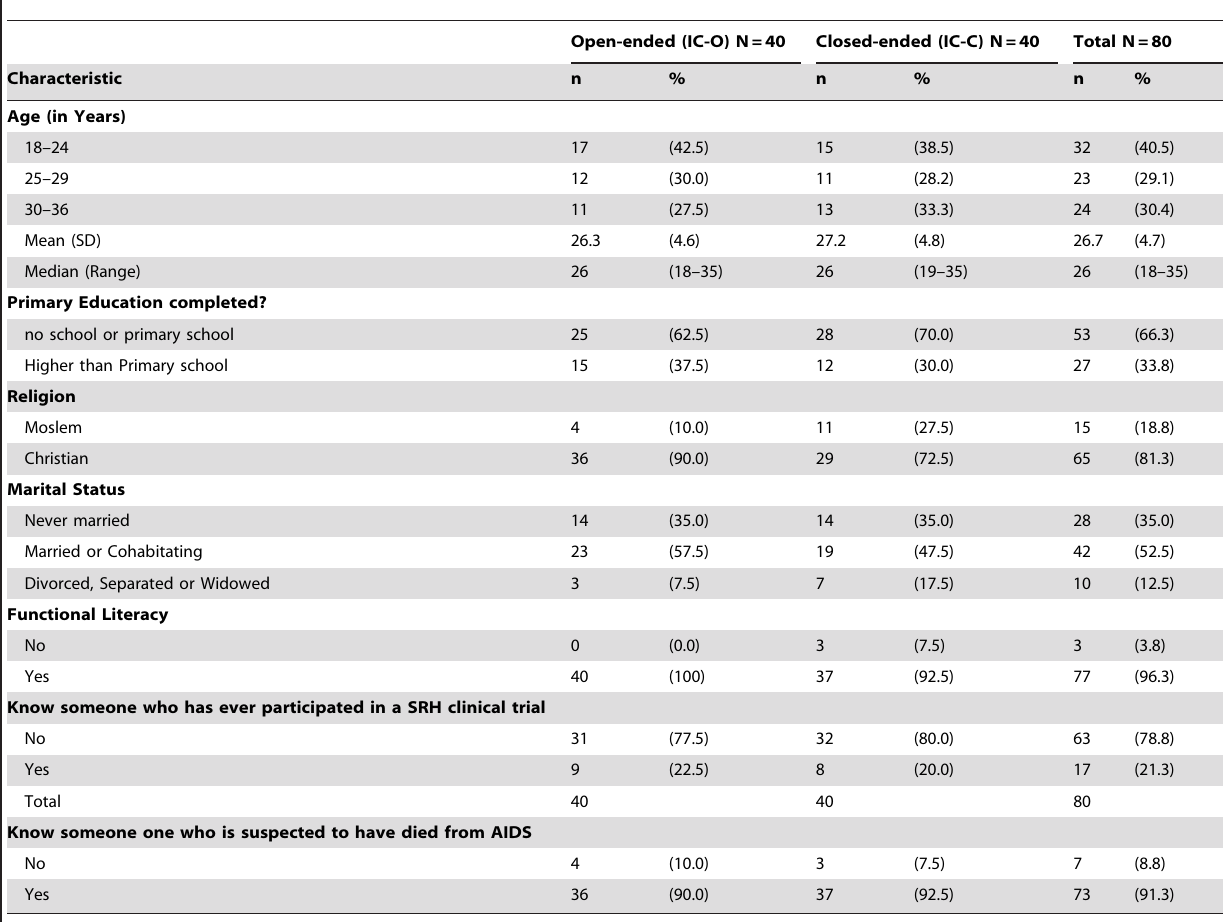
Table 2. Sociodemographic characteristics by randomization